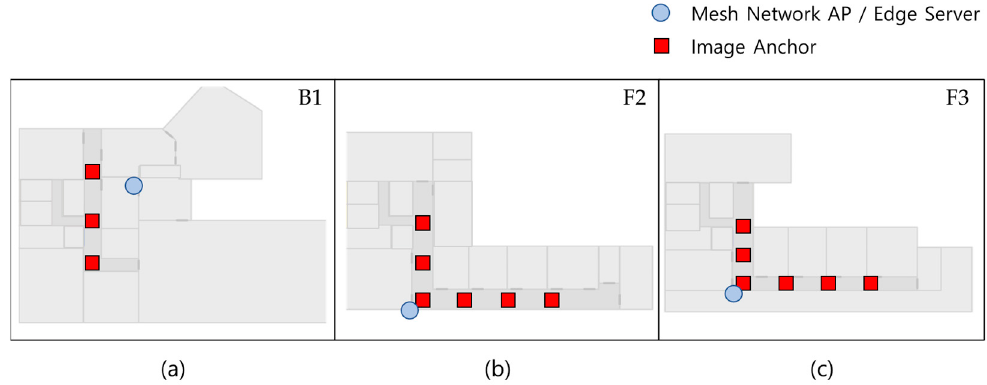
Figure 6. Test area drawings: ( a ) B1 drawing; ( b ) F2 drawing; ( c ) F3 drawing.